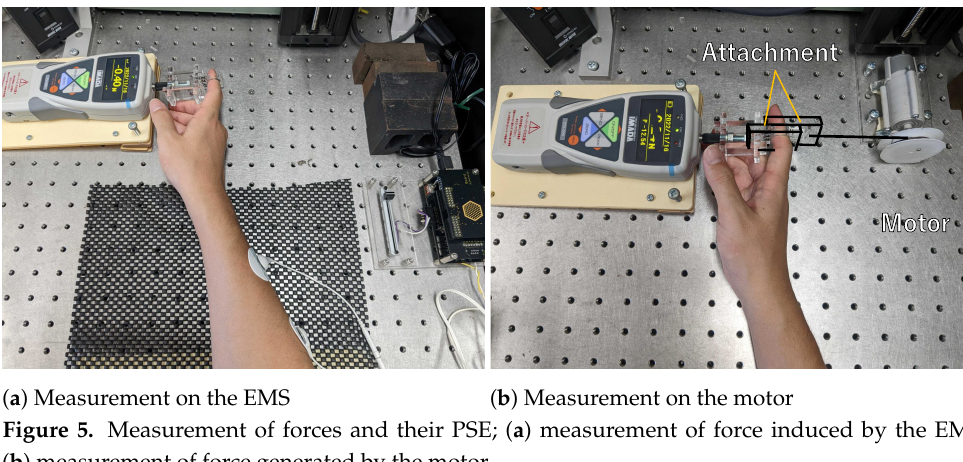
Figure 5. Measurement of forces and their PSE; ( a ) measurement of force induced by the EMS; ( b ) measurement of force generated by the motor.